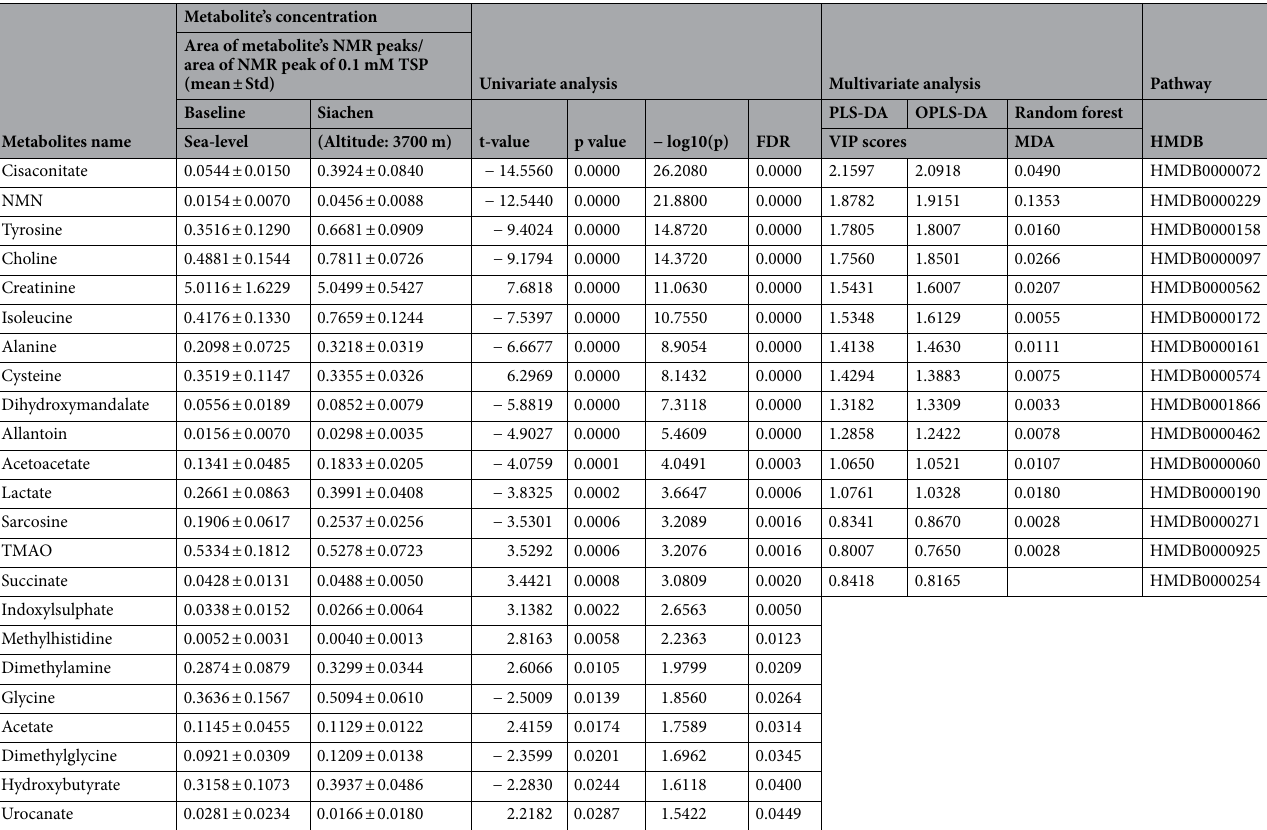
Table 1. List of 23 Key metabolites obtained from t-test responsible for discriminating sea level control group and Siachen group. p values were derived from two-tailed Student’s t test. FDR values were calculated which indicates false discovery rates.